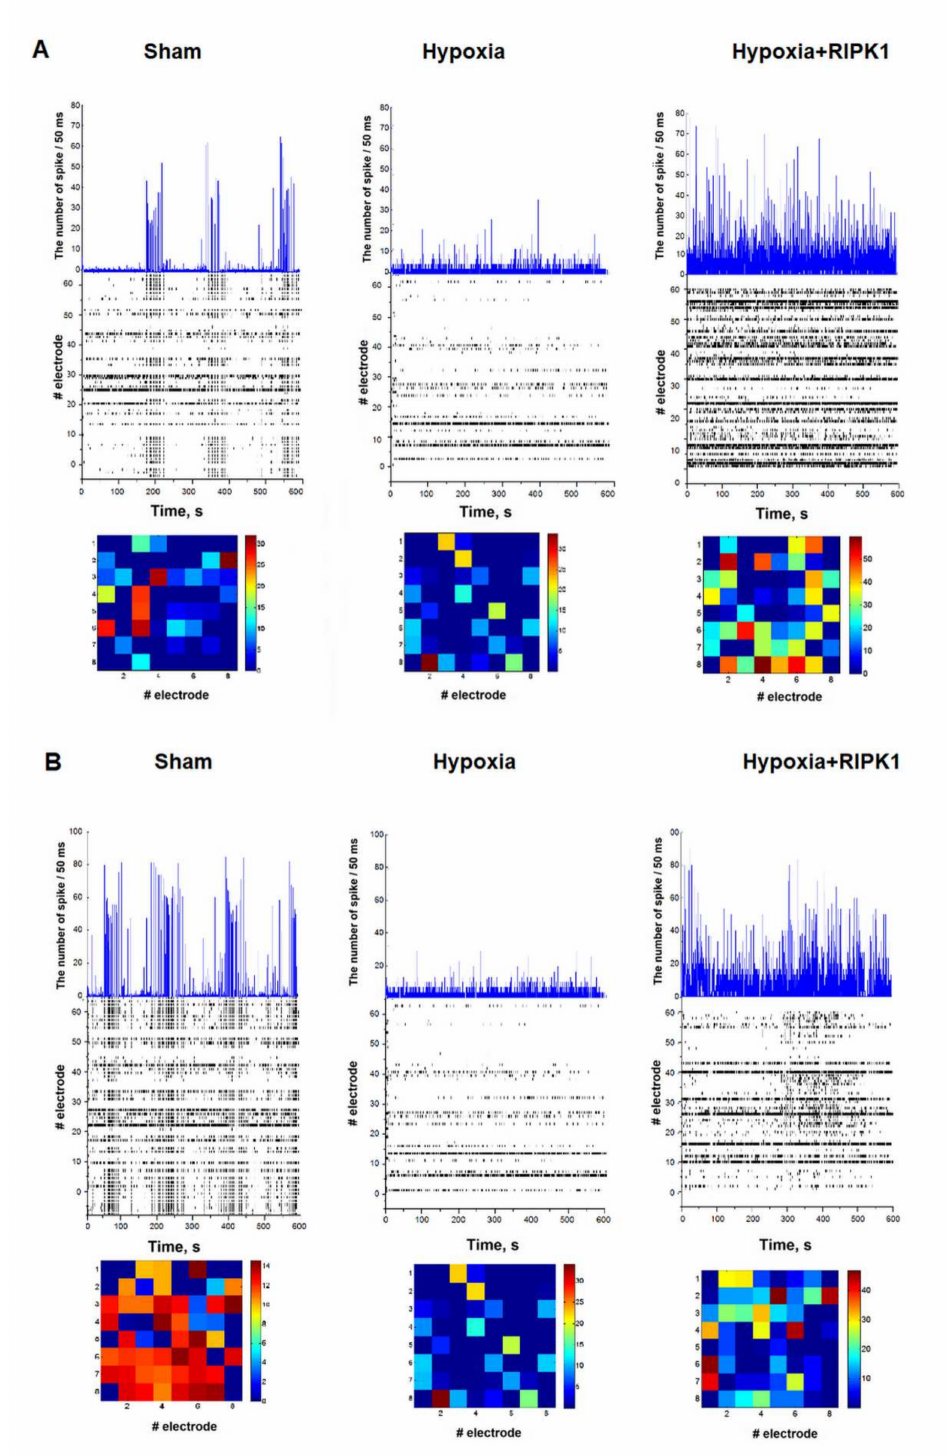
Figure 5. The number of spikes in 50 ms and typical examples of raster diagrams of spontaneous bioelectrical activity of primary neuronal cultures (top) and representative examples of patterns of spontaneous bioelectrical activity of primary neuronal cultures (bottom) on days 1 ( A ) and 7 ( B ) after modeling hypoxia. Color diagram—the time of spikes’ occurrence in the network burst, recorded from the electrodes,